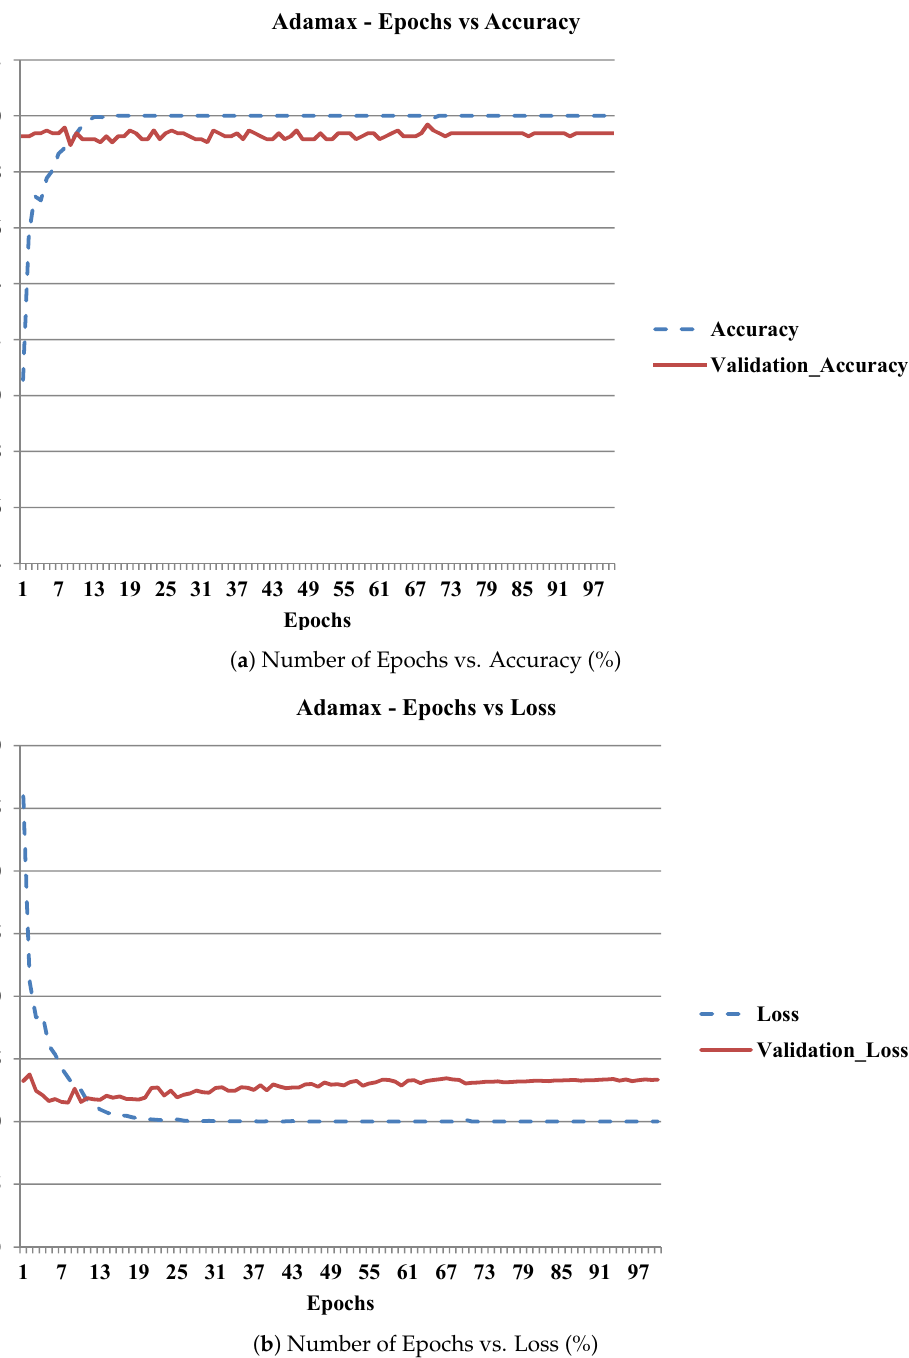
Figure 5. Accuracy and loss graph on training and validation data of Adamax